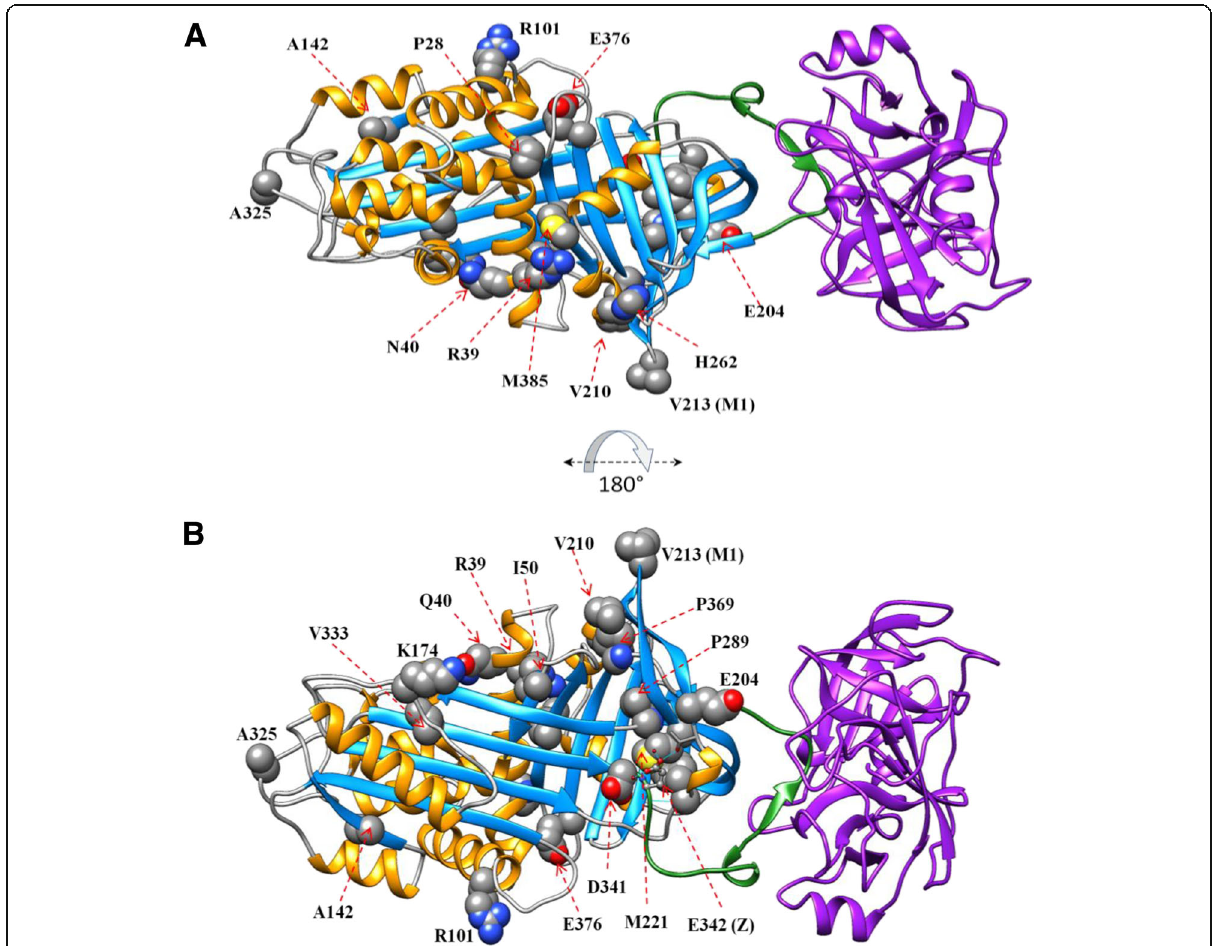
Fig. 1 Structure of AAT indicating the location of missense residues. The AAT protein (PDB code 1OPH) is shown in ribbon representation coloring according to secondary structural elements (alpha helices shown in orange, beta strands shown in light blue), and the position of missense changes showing the wildtype residue in sphere representation and labeled with the residue name and position. The purple ribbon protein is trypsinogen. The stretch of amino acids that comprise the reactive center loop are shown in green ribbon representation. A = front view; B = rear view (rotated 180 degrees about the x-axis). AAT, Alpha 1